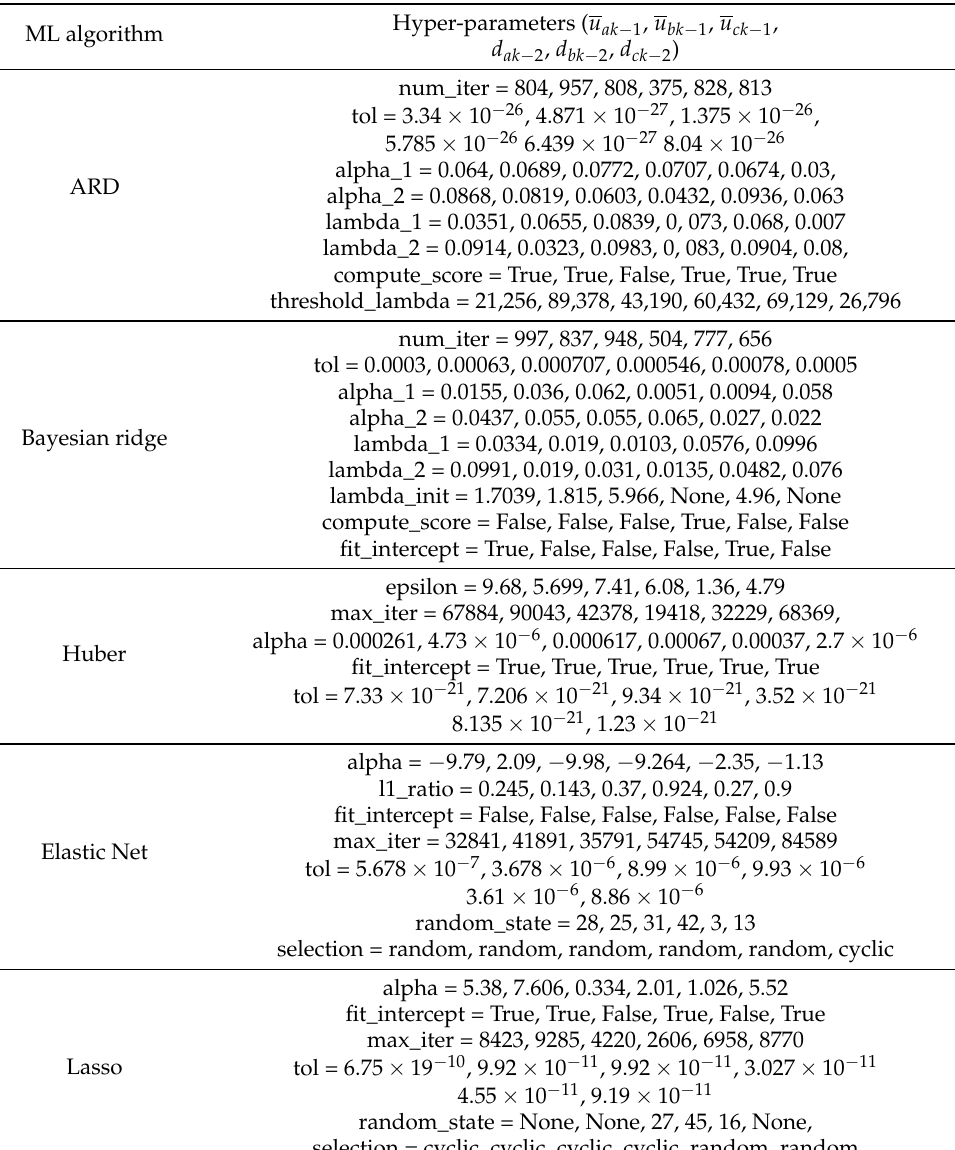
Table 14. The hyper-parameters of each ML-algorithm used in the stacking ensemble with random- ized hyper-parameter search and 5-fold